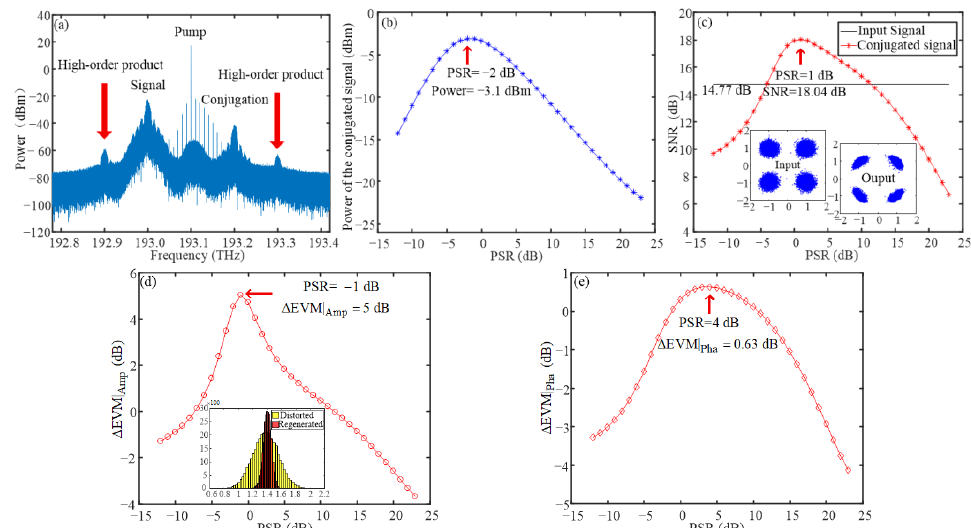
Figure 5. ( a ) Spectrogram in YF case; ( b ) power curve of the conjugated signal with PSR; ( c ) rela- tion between SNR and PSR; ( d ) the amplitude EVM gain ΔEVM| Amp ; and ( e ) the phase EVM gain ΔEVM| Pha on the input PSR.